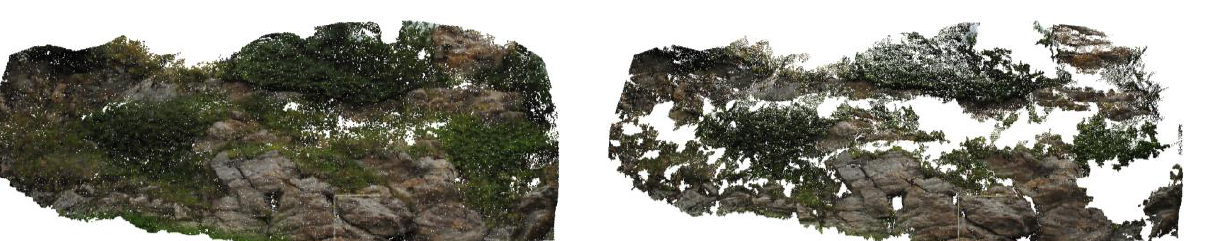
Figure 8. Agisoft PhotoScan Smartphone dense point cloud